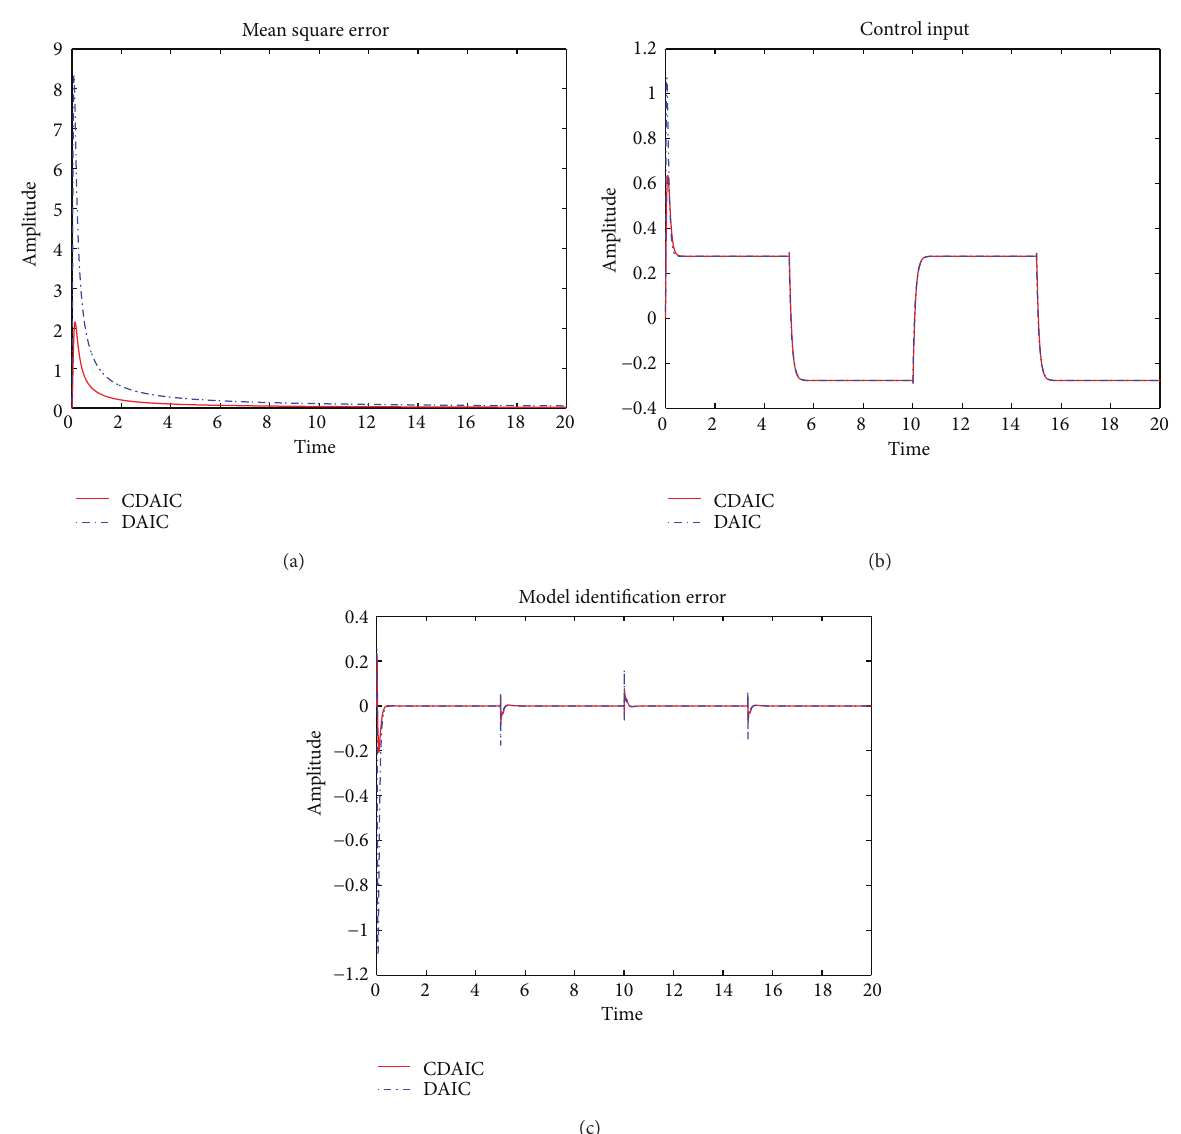
Figure 4: Example 1: simulation results: (a) mean square error; (b) control input; (c) model identification